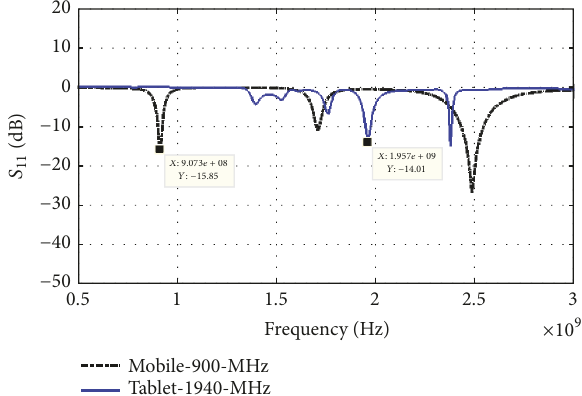
Figure 2: Reflection coefficient 𝑆 11 obtained from FDTD simula- tions in “free